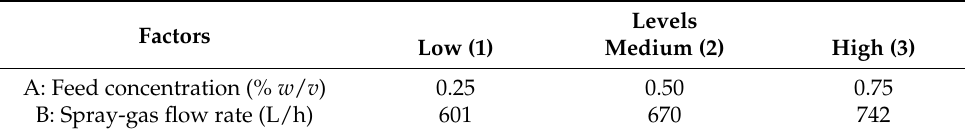
Table 1. Independent variables used in the factorial